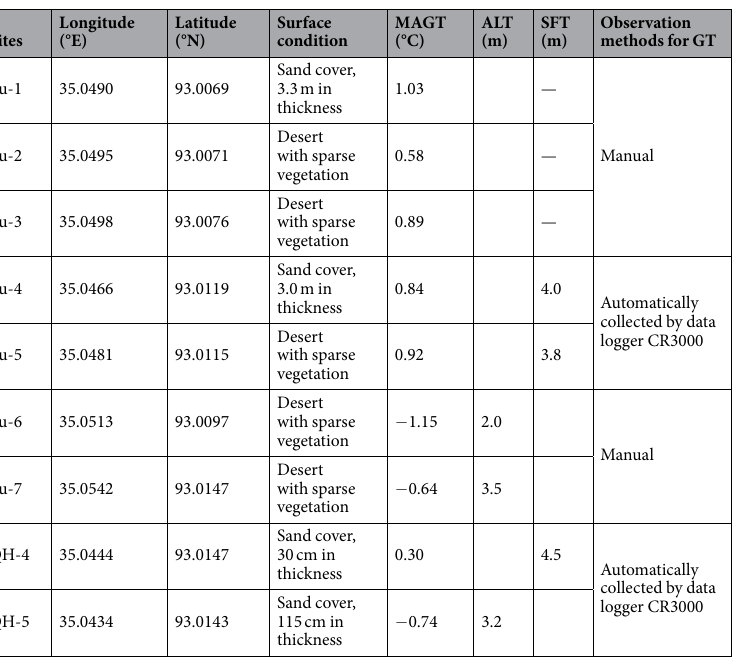
Table 1. Geographic information, surface conditions, mean annual ground temperature (MAGT), active layer thickness (ALT), seasonally frozen ground thickness (SFT) and observation methods for ground temperatures (GT) at the nine study